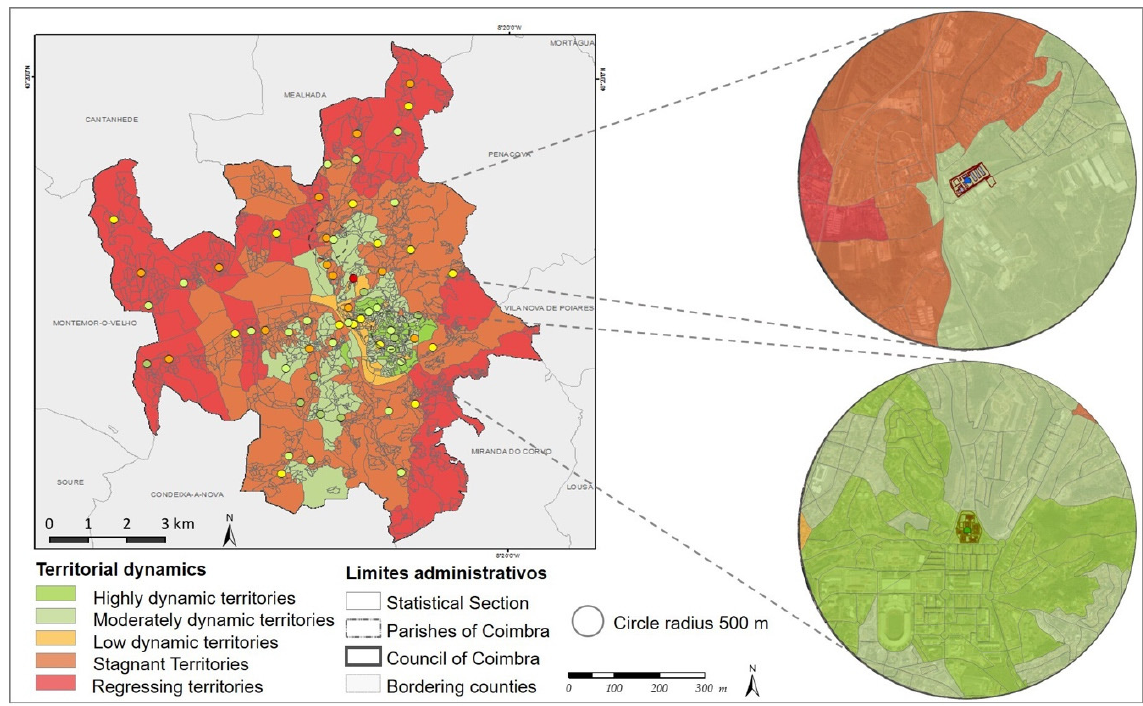
Figure 4. Socio-economic framework (based on the PCA and HCA) of the territorial environment of partner schools.